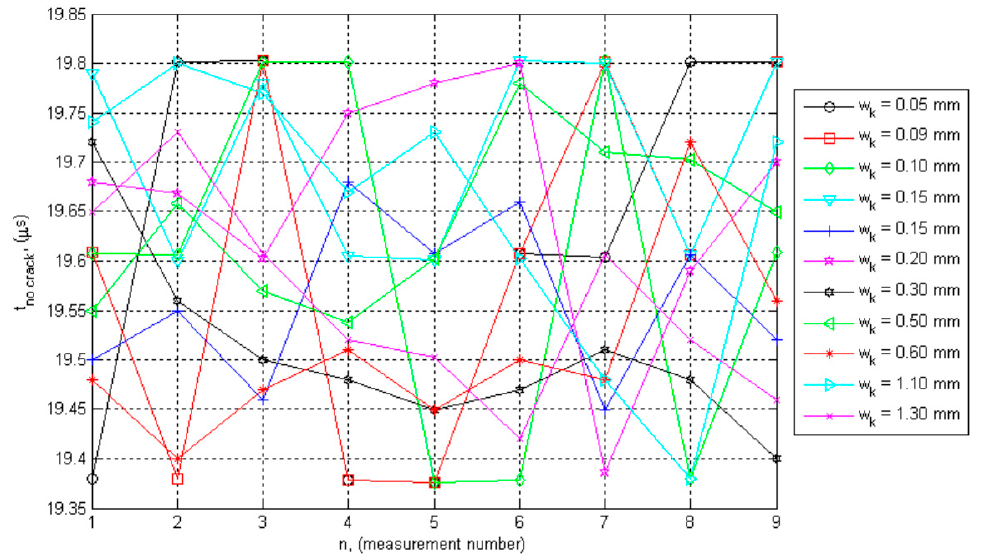
Figure 8. Transmitting time of the ultrasonic pulse t no crack in the region of the beam without a crack in an area close to the crack for the corresponding crack widths.